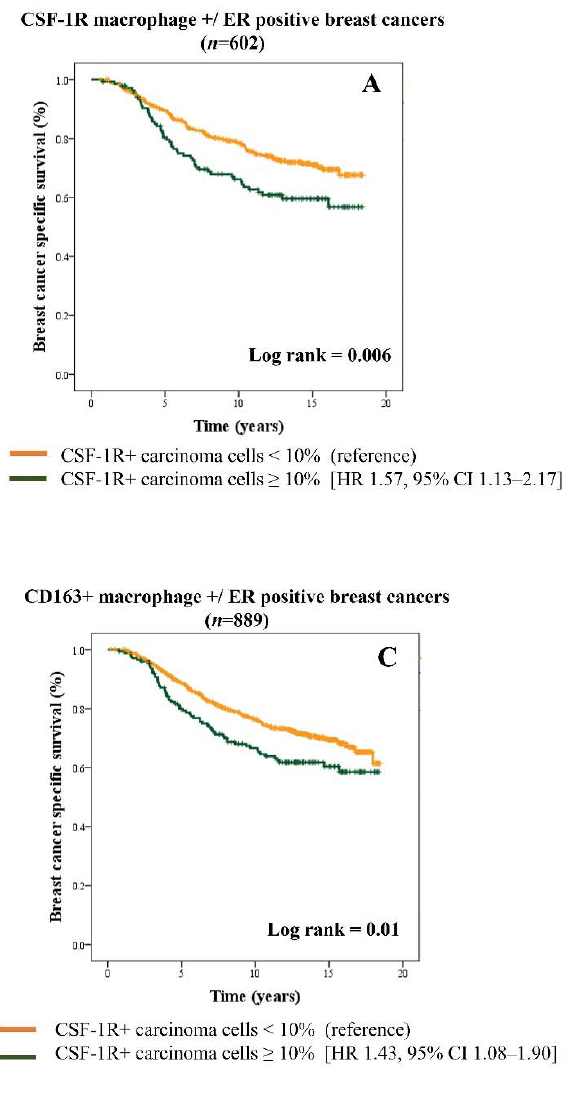
Figure 5. Kaplan–Meier survival curves showing breast cancer-specific survival in combined BC Cancer series in the presence of CSF-1R+ macrophages stratified by CSF-1R+ carcinoma cells in ER-positive ( A ) and ER-negative cases ( B ). Kaplan–Meier curves in the presence of CD163+ macrophages stratified by CSF-1R+ carcinoma cells in ER-positive ( C ) and ER-negative cases ( D ).